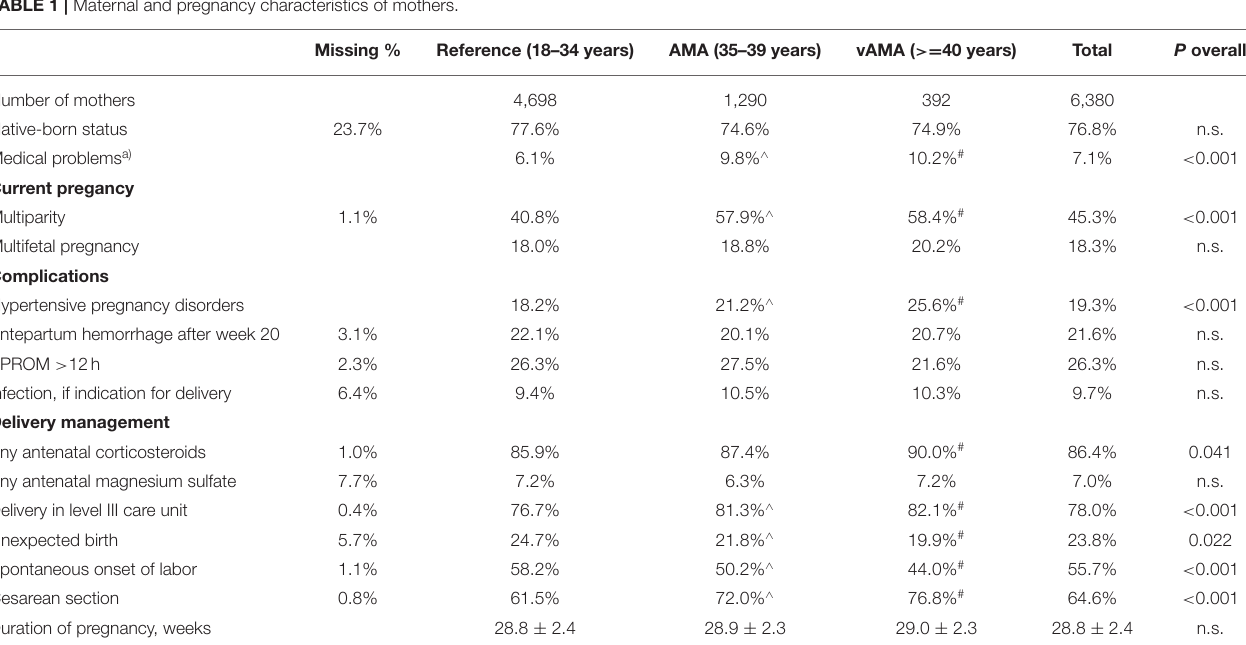
TABLE 1 | Maternal and pregnancy characteristics of